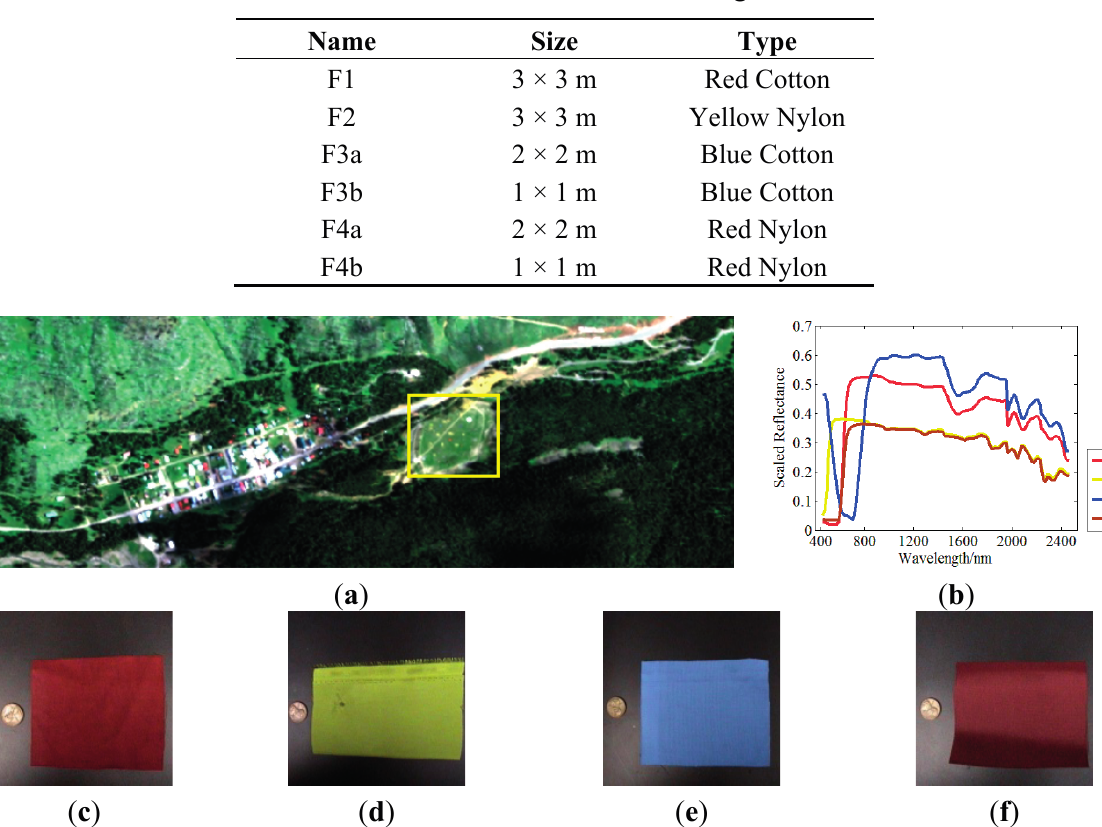
Table 2. Characteristics of real targets.